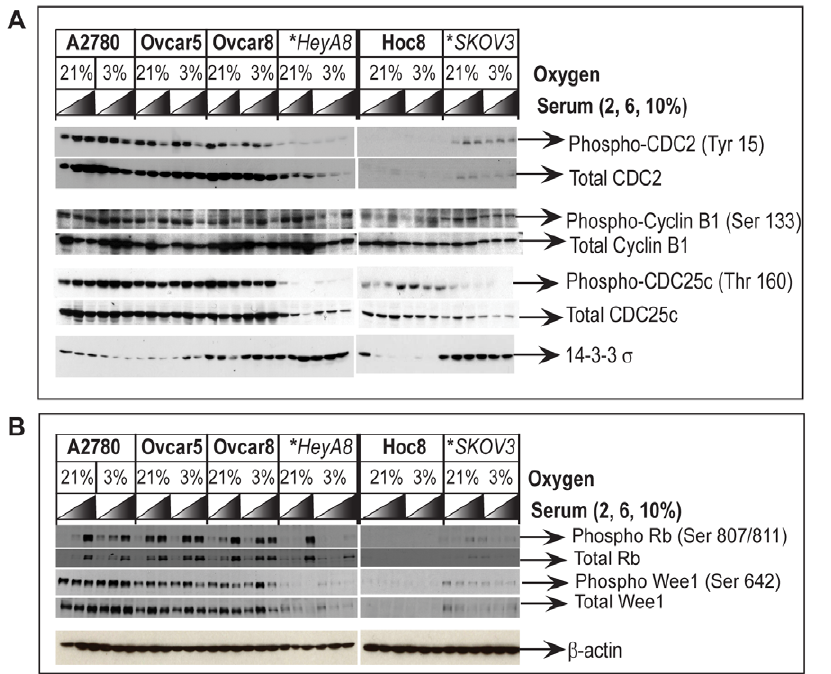
Figure 4. Western blot analysis of G2 cell cycle regulatory proteins and the relevance to O 2 sensitivity in the ovarian cancer cell lines. Protein lysates prepared from the ovarian cancer cell lines maintained in growth medium consisting of increasing concentrations of serum and 21% or 3% O 2 were analyzed by Western blot. (A) Compared to O 2 sensitive cell lines, decreased expression of the core components involved in G2/M cell cycle progression CDC2/cyclin B1 complex and its activator CDC25c is observed in the O 2 insensitive cell lines (indicated by asterisk and italics), while the expression of 14-3-3 s , a protein that inhibits CDC2 is elevated in the O 2 insensitive cell lines. (B) Phosphorylation of RB and Wee1 were monitored as an indicator for CDC2 function because both RB and Wee1 are known targets for phosphorylation by CDC2. Equal loading of protein extracts were monitored by probing the stripped Western blots with the primary antibody for b -actin.